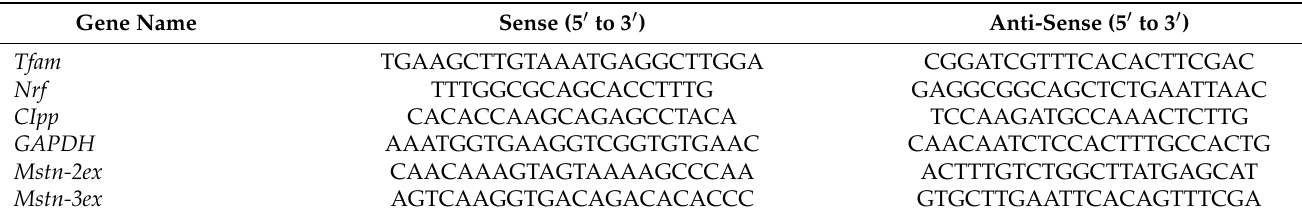
Table 3. Primers used for real-time PCR and genotyping